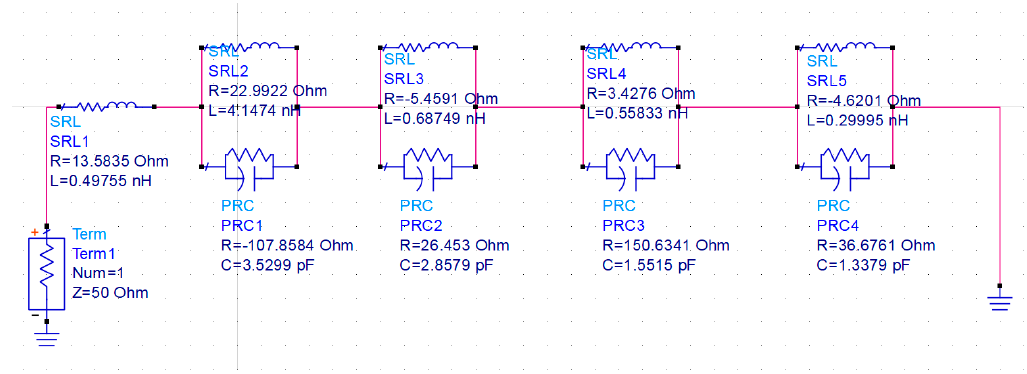
Figure 4. Comparison of the fitted rational vector function (FRVF) and simulated data (data): ( a ) impedance; ( b ) admittance.